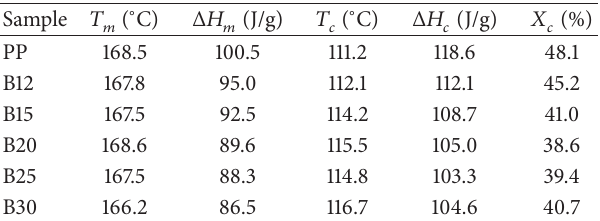
Table 3: DSC data for the PP component in the PP/PET